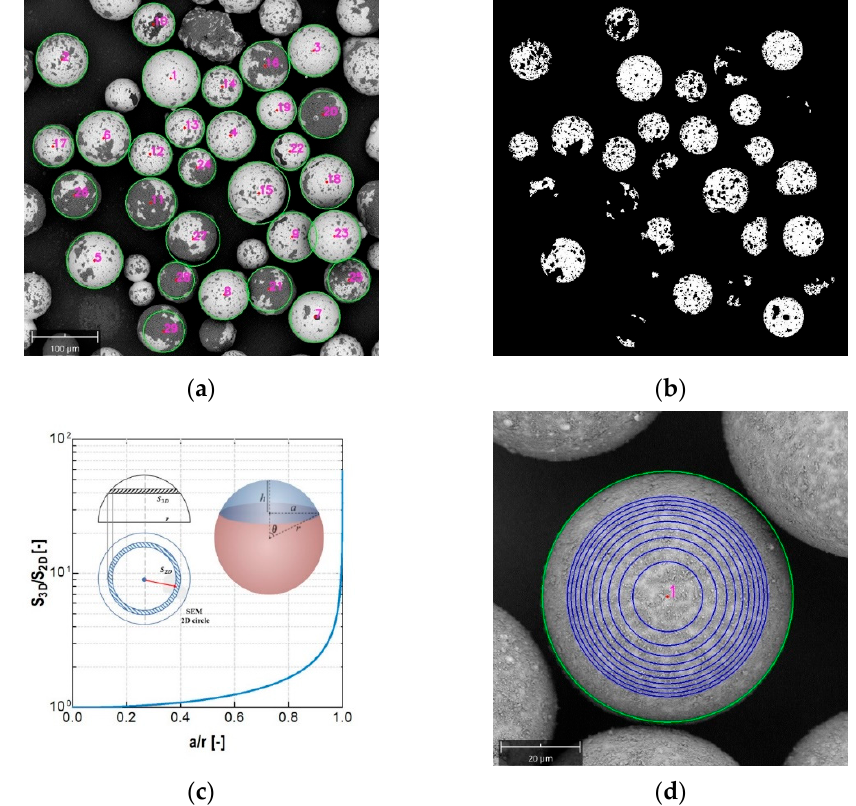
Figure 6. ( a ) Pretreatment of SEM pictures by Hough circle detection. ( b ) Processed binary picture for the calculation of coating coverage. ( c ) Ratio of S 3D to S 2D with respect to the distance to particle center. ( d ) Area subdivision of the image error elimination method.